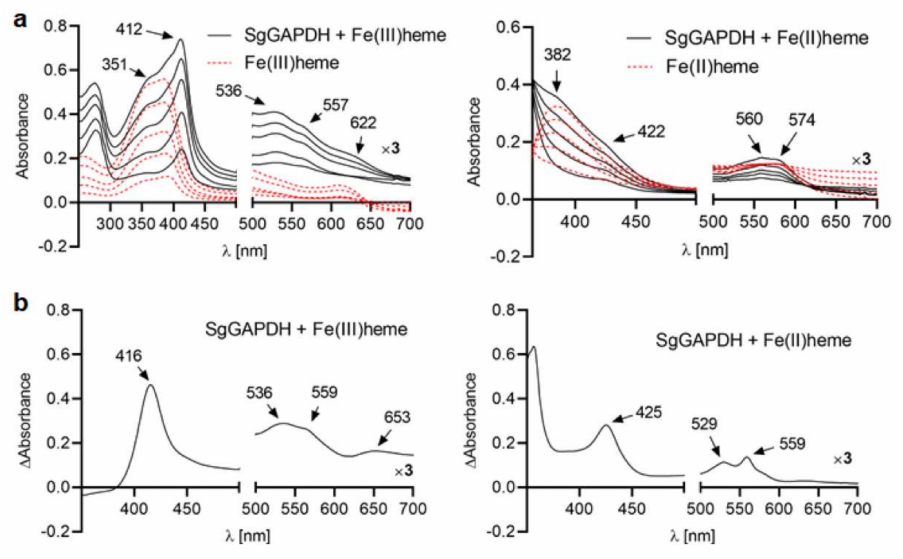
Figure 3. Heme titration of SgGAPDH. ( a ) UV-visible absorption and ( b ) di ff erence spectra recorded after titration of SgGAPDH (10 µ M) with heme (final heme concentration in samples: 0–10 µ M) are shown. Various lines in ( a ) represent increasing concentrations of heme added to the bu ff er alone (red dashed lines) or to protein samples (solid black lines). Samples were examined under air (oxidizing) conditions (left panel) or reduced by sodium dithionite (right